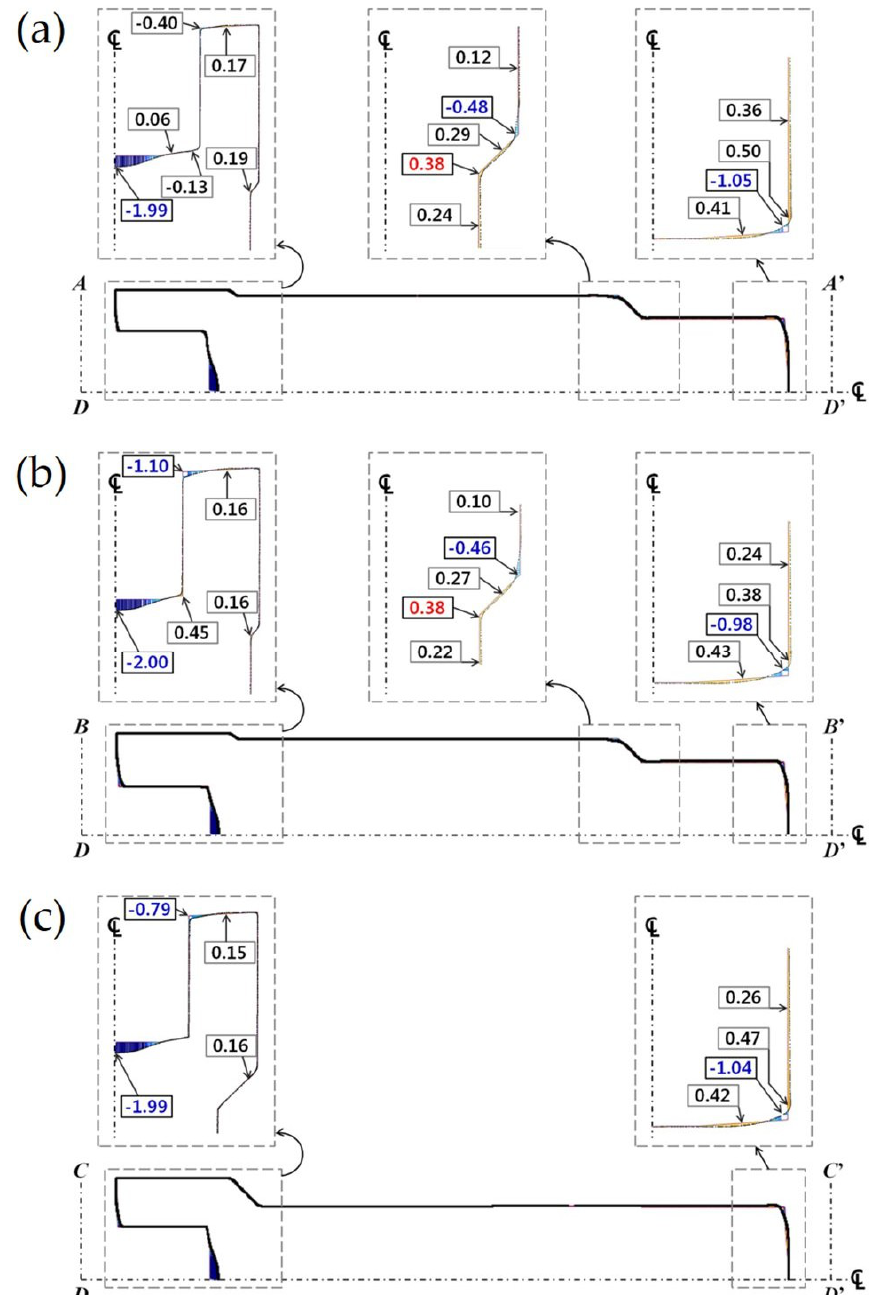
Figure 12. Dimensional variation between 3D scanned image and target shape of the drive shaft (unit: mm): ( a ) Shape comparison on DA - D ’ A ’ cross-sectional plane (top land direction); ( b ) Shape comparison on DB - D ’ B ’ cross-sectional plane (top land direction); ( c ) Shape comparison on DC - D ’ C ’ cross-sectional plane (bottom land direction).